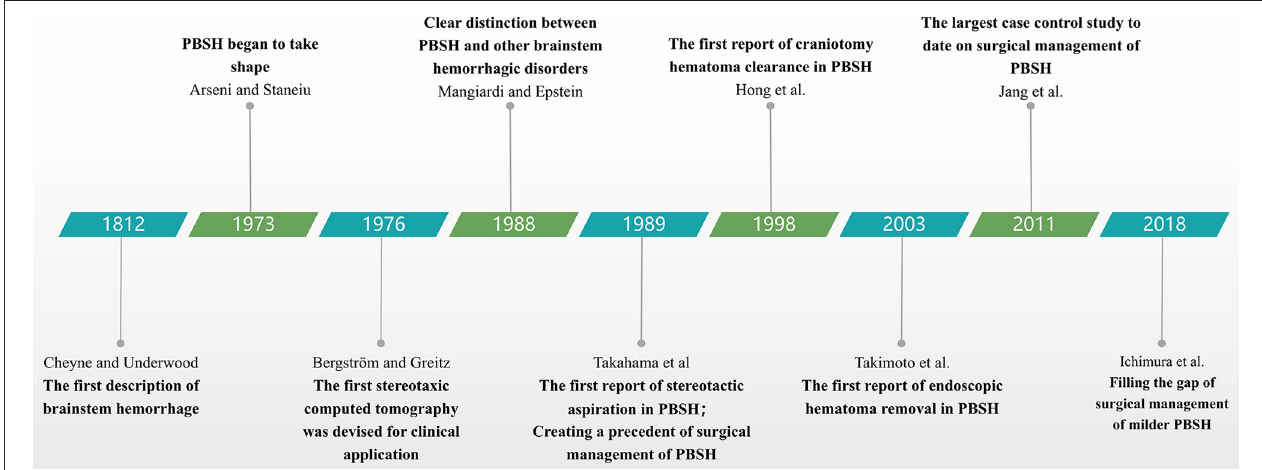
FIGURE 1 | Timeline diagram depicting major milestones for surgical management of PBSH. PBSH, primary brainstem